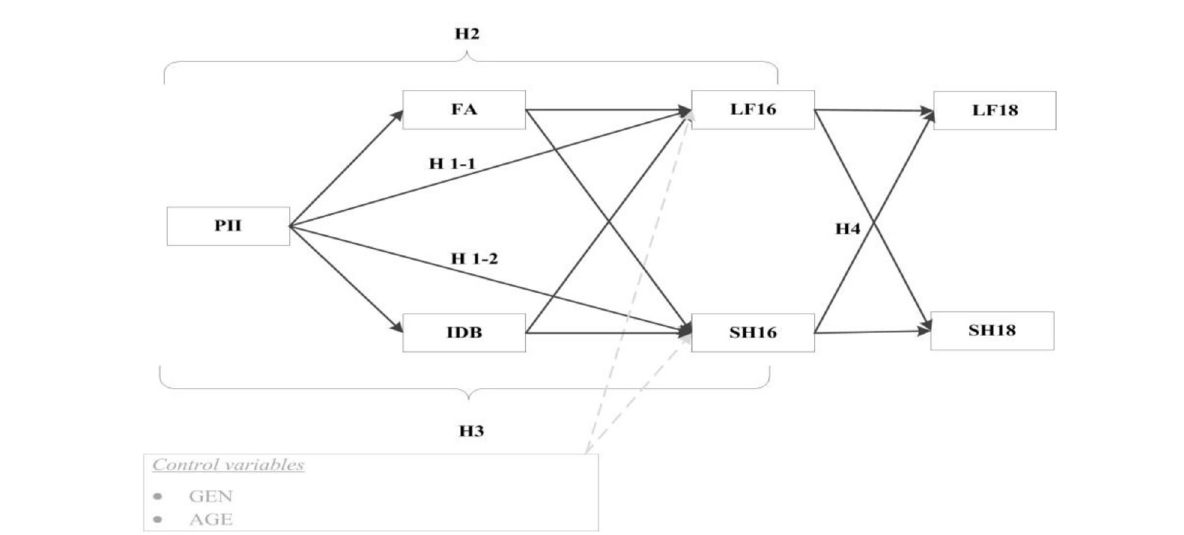
FIGURE1 Hypothesized model of the research framework. PII, perceived importance of the Internet; FA, family atmosphere; IDB, independent behavior; LF16, life satisfaction in 2015–2016; SH16, self-rated health in 2015–2016; LF18, life satisfaction in 2017–2018; SH18, self-rated health in 2017–2018.